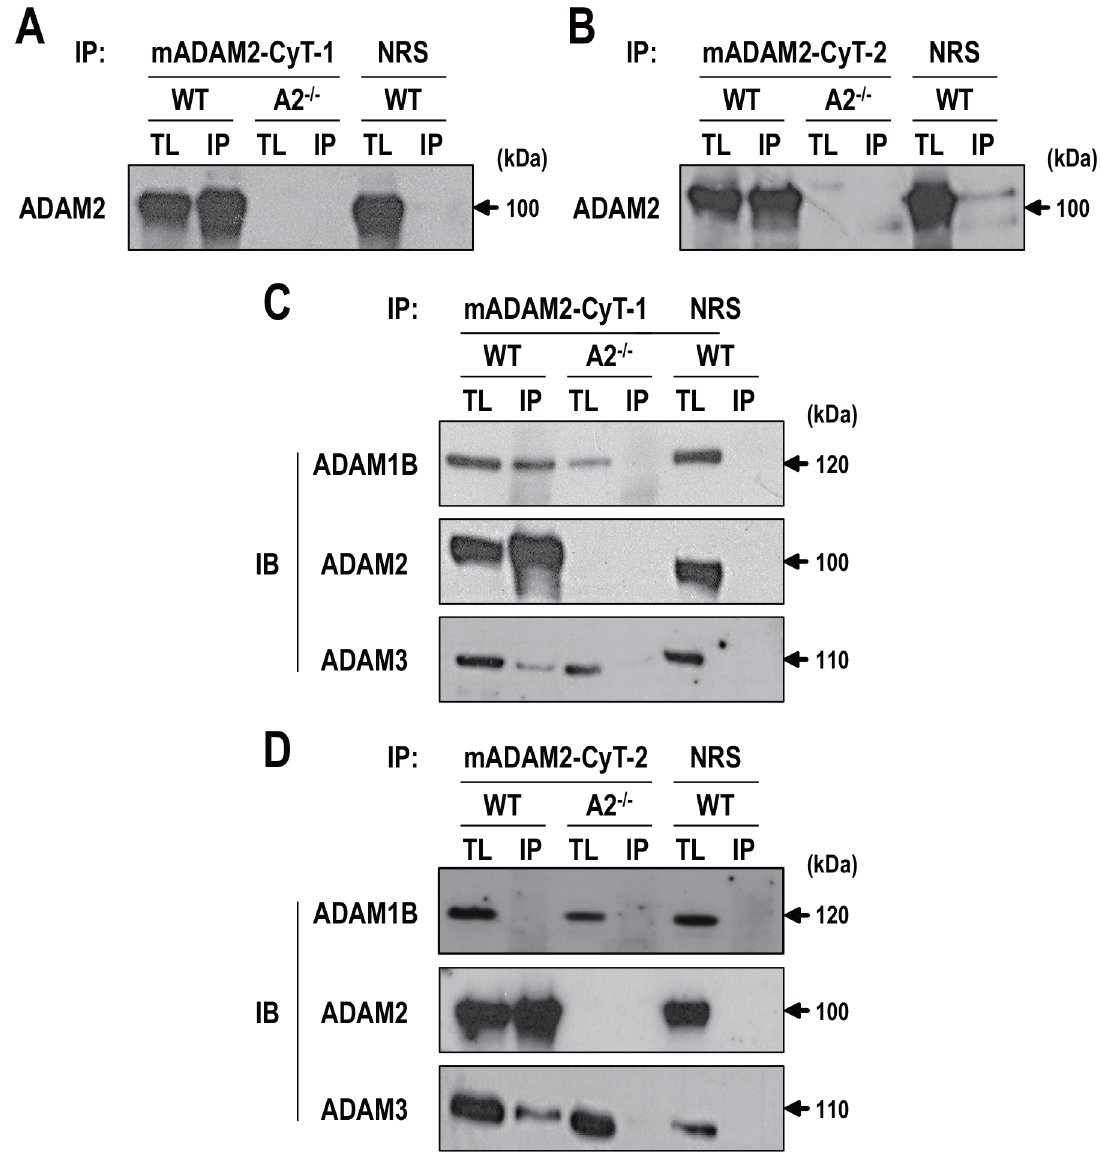
Fig 2. Coimmunoprecipitation of ADAM2 in mouse testes. A and B . Testes from wild-type and Adam2 -/- mice were lysed with 1% NP-40 buffer, the tissue lysates were immunoprecipitated with A . anti-mADAM2-CyT-1 and B . anti-mADAM2-CyT-2, and the resolved immunoprecipitates were immunoblotted with anti-mADAM2-D. Normal rabbit serum was used as a control. C and D . Lysates were precipitated with C . anti-mADAM2-Cyt-1 and D . anti-mADAM2-CyT-2 and analyzed by immunoblotting with anti-mADAM2-D, anti-mADAM1B, and anti-mADAM3. Experiments were repeated five times. Reduced protein samples were subjected to SDS-PAGE using 8% resolving gels. Abbreviations: WT, wild-type; A2 -/- , Adam2 -/ ; TL, tissue lysate (100 μ g); IP, immunoprecipitated protein (1 mg); NRS, normal rabbit serum; and IB, immunoblotting.